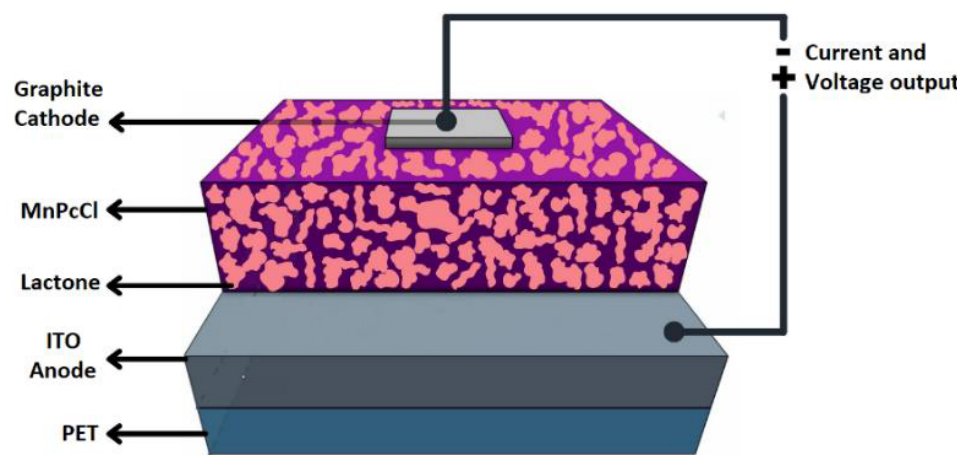
Figure 6. Cross section of the device.